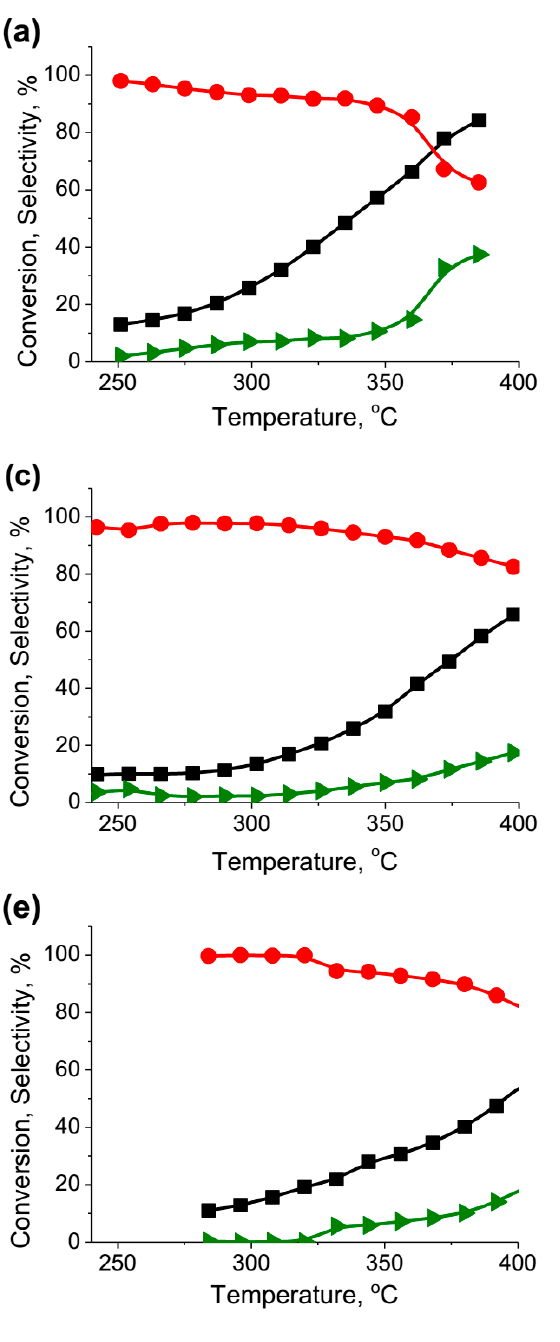
Figure 6. Catalytic performance of ( a ) Co@NC-Gr, ( b ) Co@NC-ZIF, ( c ) Co@NC-Gr SA , ( d ) Co@NC-ZIF SA , ( e ) Co@C-Gr and ( f ) NC-Gr catalysts as a function of temperature: conversion of ethanol ( ■ ) and selectivities toward acetaldehyde ( ● ) and ethylene ( ► ). Gas mixture: 5 vol.% EtOH, He balance; GHSV ≈ 18,000 h − 1 .